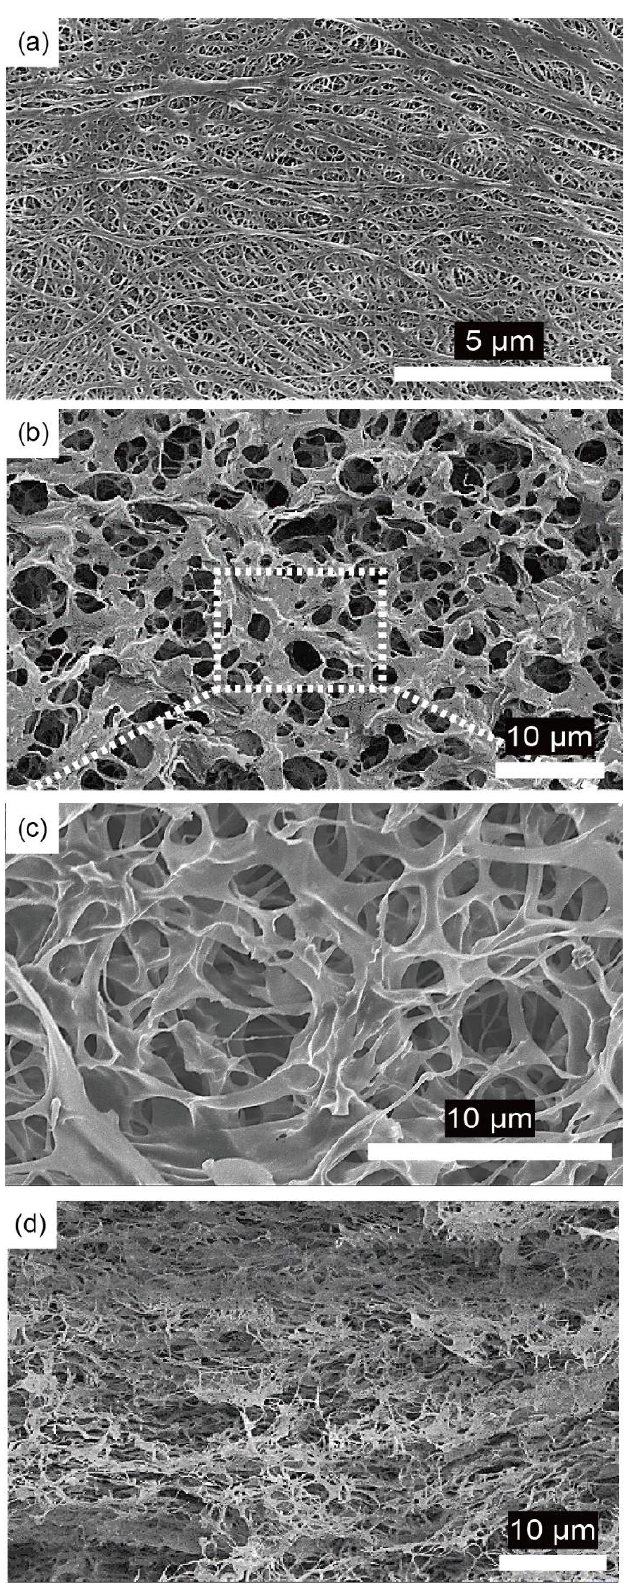
Figure 2. Surface scanning electron microscopy (SEM) images of ( a ) bare polyethylene (PE) separators and ( b , c ) porous PI separators. The cross-sectional SEM image of ( d ) porous PI separators. To investigate the wettability of separators, the droplet size and contact angle were observed after dropping droplets of the liquid electrolyte (150 μL of 1.1 5 M LiPF 6 in EC/EMC (3/7, by vol.)) onto both types of separators (bare PE and porous PI separators). The droplets on the porous PI separators quickly spread over the separators. In contrast, the original size of the liquid electrolyte